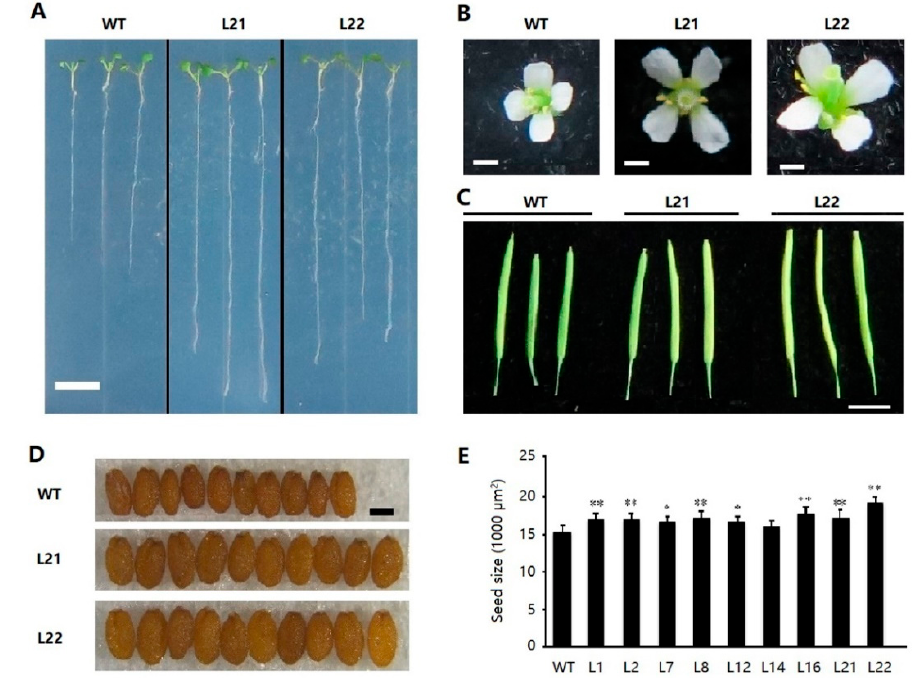
Figure 6. Overexpression of FvSPL10 in Arabidopsis enlarges plant organs. Wild-type (WT) Arabidopsis ; L21, L22, transgenic lines with overexpression of FvSPL10 . ( A ) Roots of 7-day-old WT and transgenic plant seedlings. Scale bar, 10 mm. ( B ) Floral organs of WT and transgenic plants. Scale bar, 1 mm. ( C ) Siliques of WT and transgenic plants. Scale bar: 10 mm. ( D ) Mature seeds of WT and transgenic plants. Scale bar: 0.1 mm. ( E ) Statistics of seed size between WT and transgenic plants. Seed